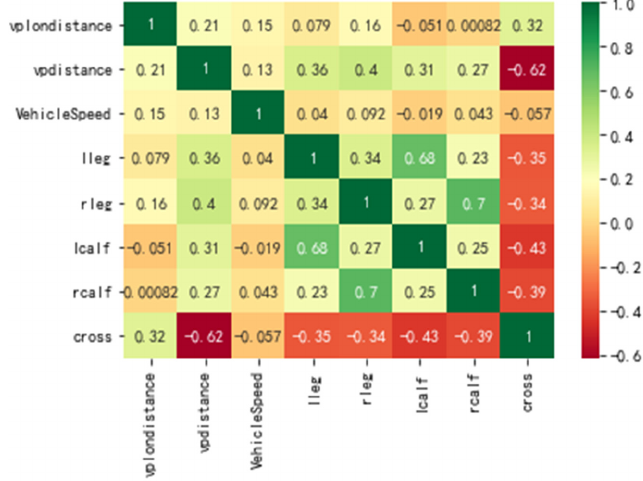
Figure 14. Correlation coefficient matrix.